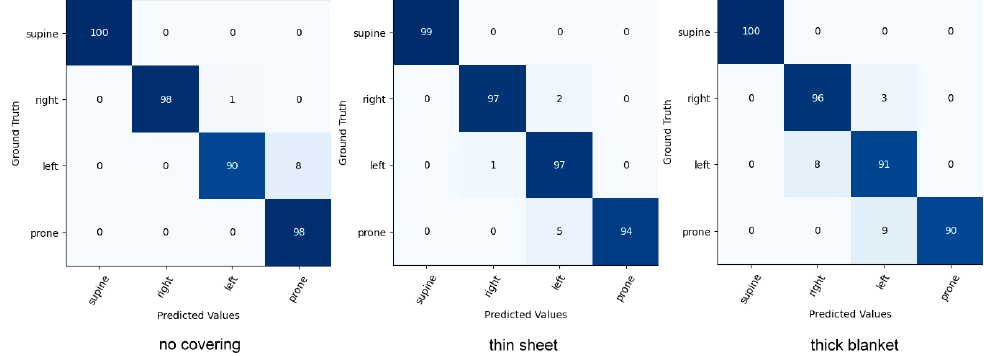
Figure 10. Confusion matrix for head pose classification on the iSP pilot dataset.